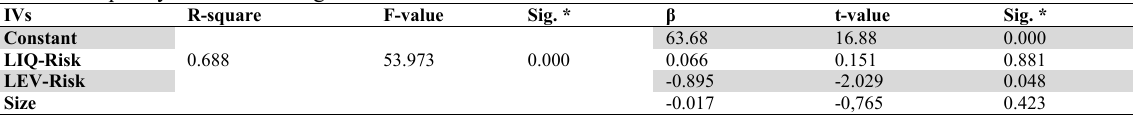
Effects of liquidity risk and leverage risk on